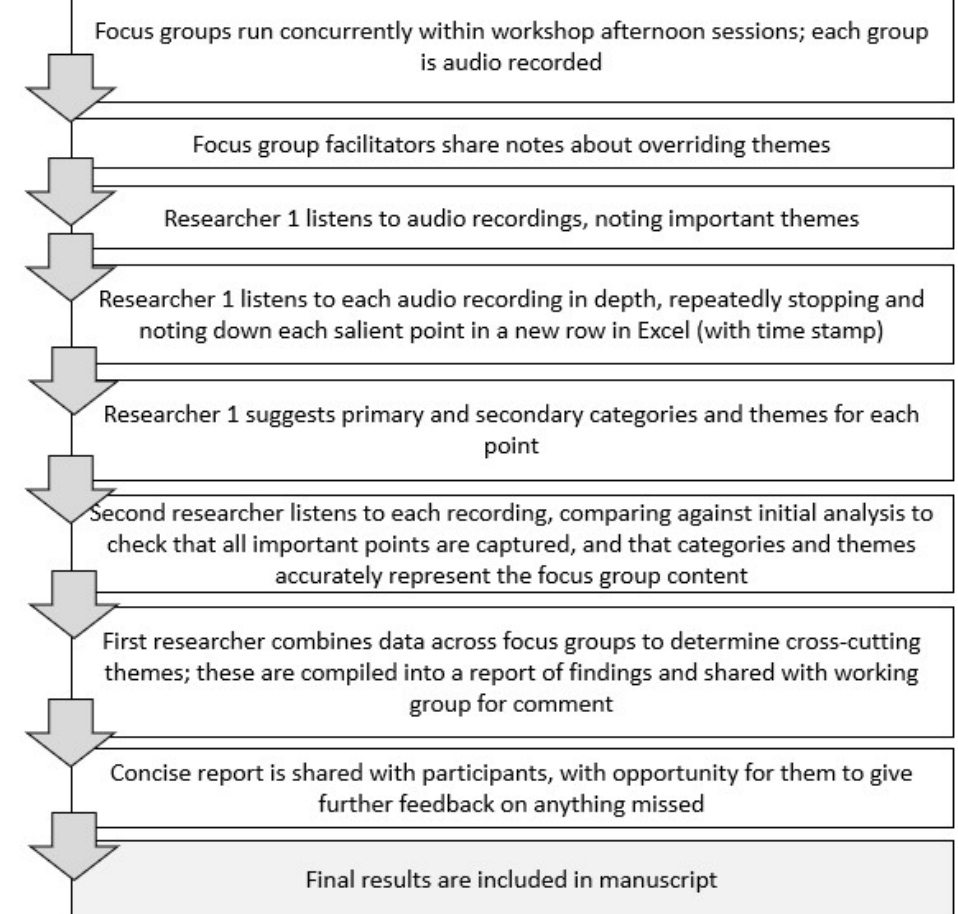
Figure 1. Step-by-step s tages followed in the analysis of the focus group